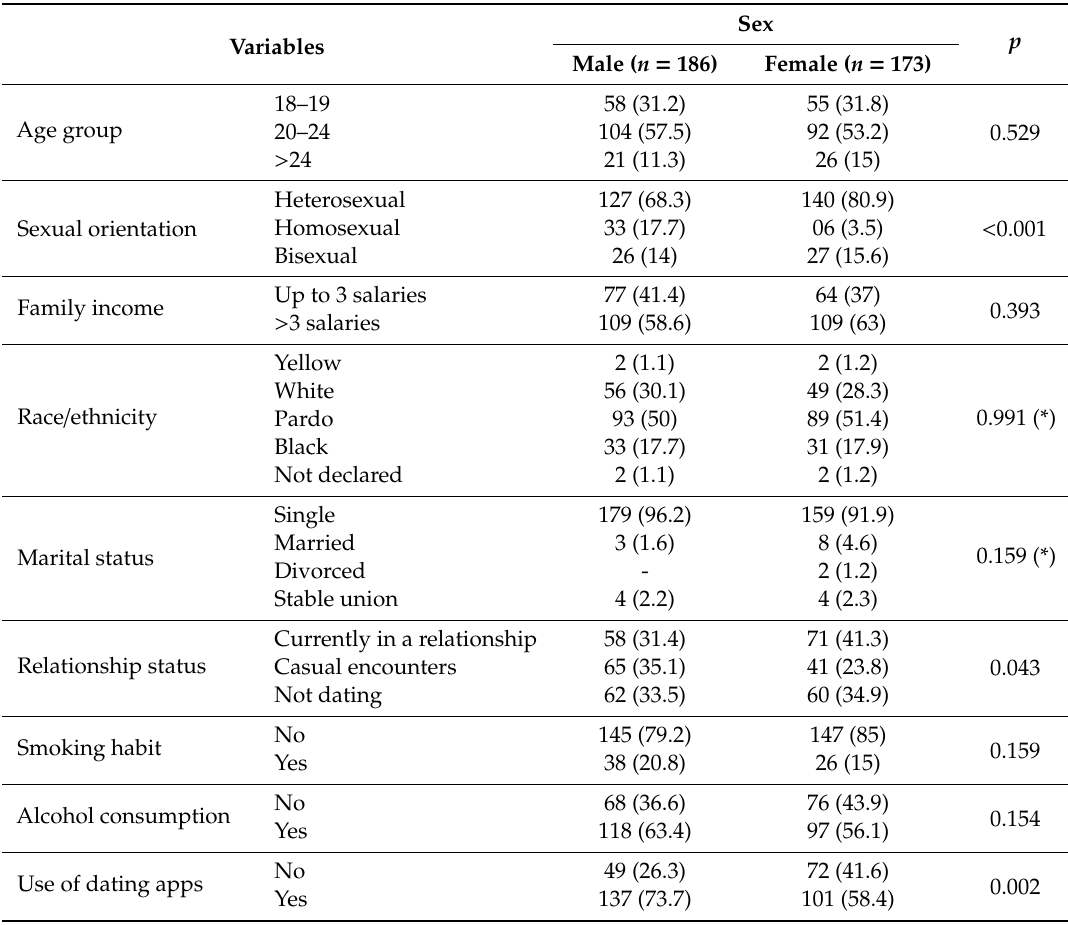
Table 1. Bivariate analysis of the sociodemographic characteristics of students at the Federal University of Tocantins, Palmas campus ( n = 359), n